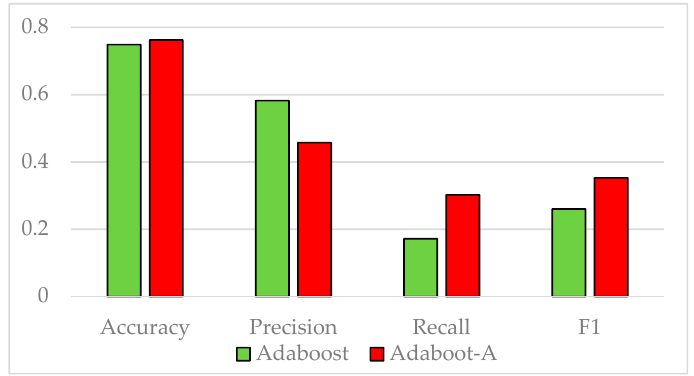
Figure 6. Performance Comparison on KC1 Test Set.